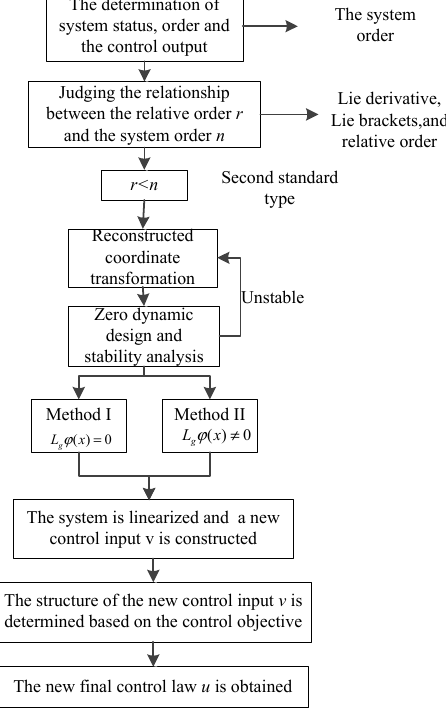
Figure 4. Feedback linearization control law flowchart.